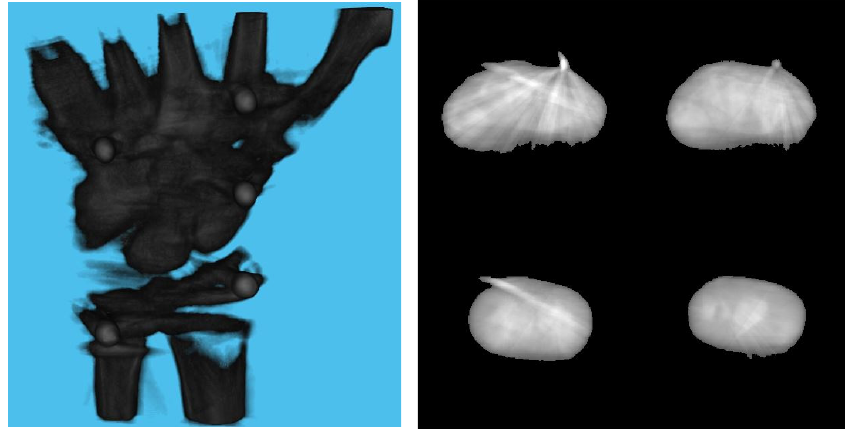
Figure 12. Volume rendering of the reconstructed volume using a 5 mm calibration board and 6 mm marker ( left ). Four fixed slices (top left: metacarpals, top right: carpals, bottom right: carpals, bottom left: radius and ulna) of the volume ( right ).